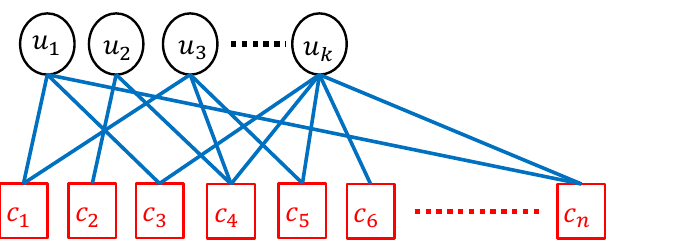
Figure 2. The encoding process of LT codes, where k source symbols (circles) are used to generate n encoded symbols